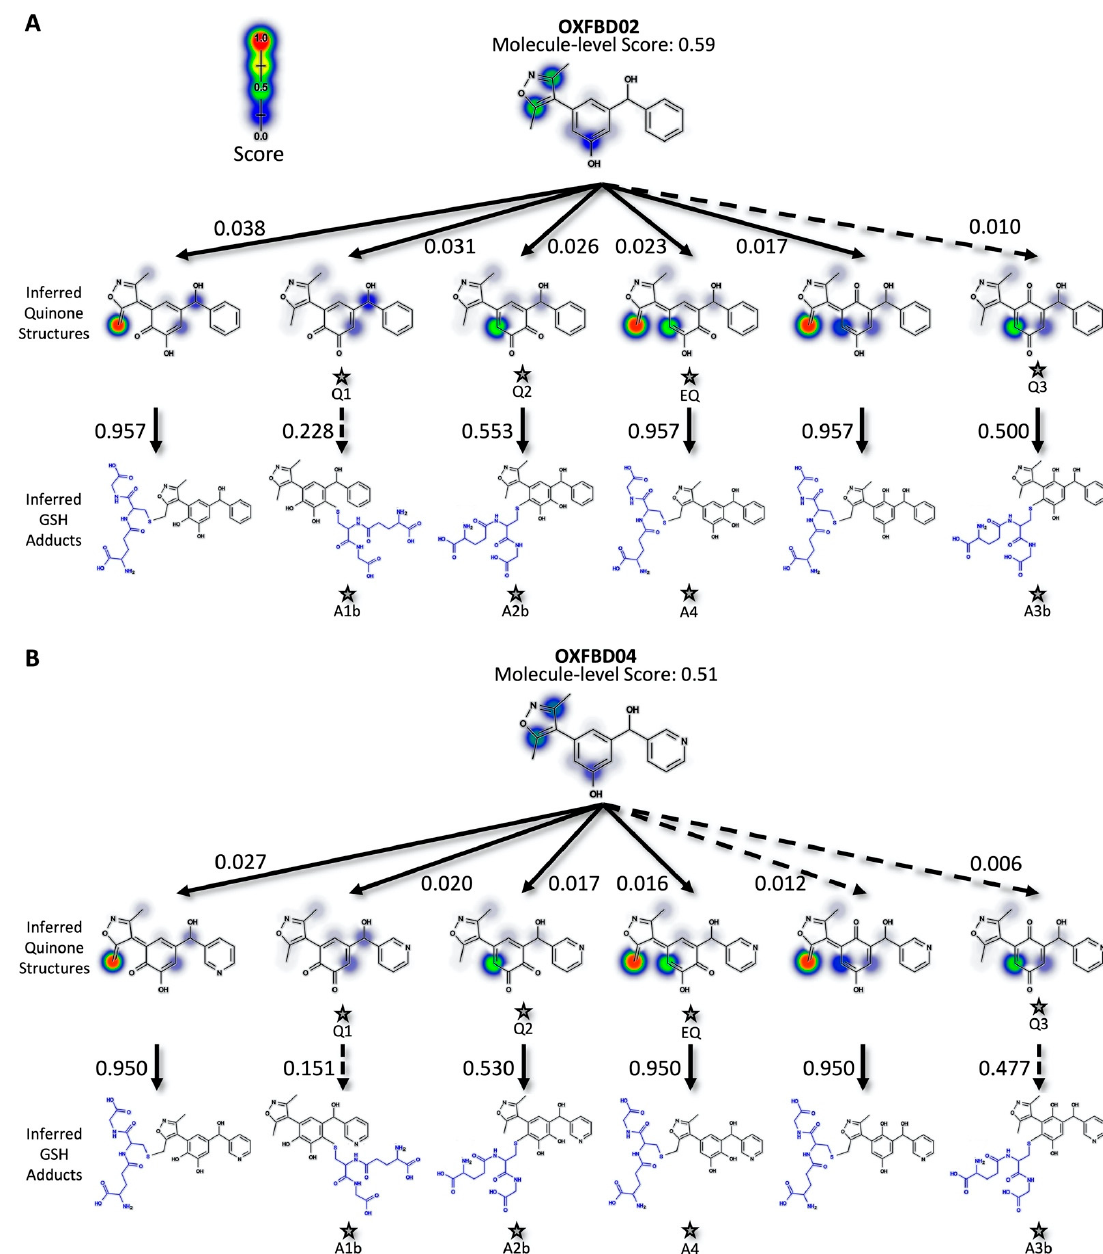
Figure 2. Predicted bioactivation pathways and subsequent adducts for OXFBD molecules. ( A ) Top six model-derived bioactivation pathways for OXFBD02. The top six pathways split evenly between traditional (Q) and extended quinone- methides (EQ) involving the isoxazole and are ranked based on the indicated quinone model score. EQs were highly reactive to glutathione but traditional quinone reactivity was only moderate to low, as reflected in the reactivity prediction values. Dashed arrows denote the transformations for which the predictions are below the model’s binarization threshold. Stars show the predicted glutathione adducted metabolites observed experimentally (Figure 3). ( B ) The top six pathways split evenly between traditional (Q) and extended quinone-methides (EQ) and are ranked based on the indicated quinone model score. EQs were highly reactive to glutathione but traditional quinone reactivity was only moderate to low, as reflected in the reactivity prediction values. Dashed arrows denote the transformations for which the predictions are below the model’s binarization threshold. Stars show the predicted glutathione adducted metabolites observed experimentally (Figure